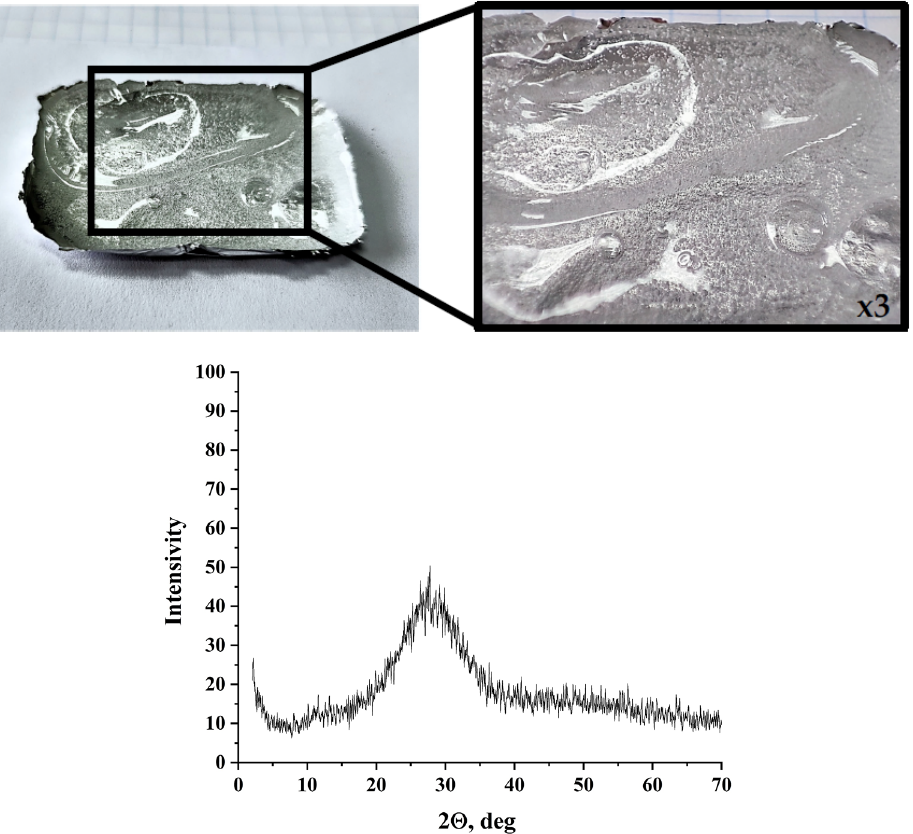
Figure 7. Appearance and XRD data of the aqueous solution of sodium silicate (Na 2 O · 2,87SiO 2 ) aq after heat treatment at 100 °C with exposure of 24 h.